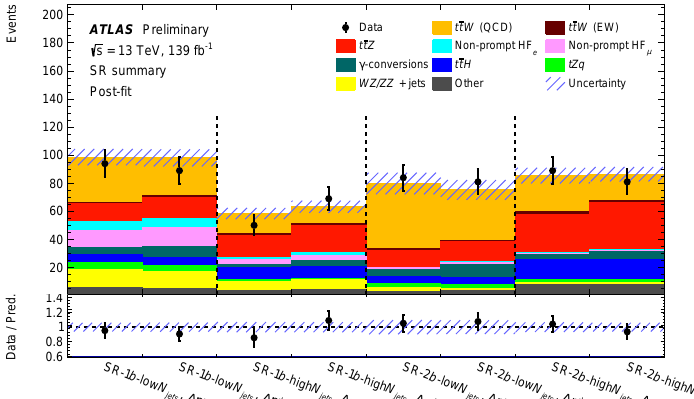
Figure 30. Comparison between data and the post-fit predictions for ∆ | η | ≤ 0 and ∆ | η | > 0 in the four signal regions used to compute the t ¯ tW charge asymmetry in ATLAS